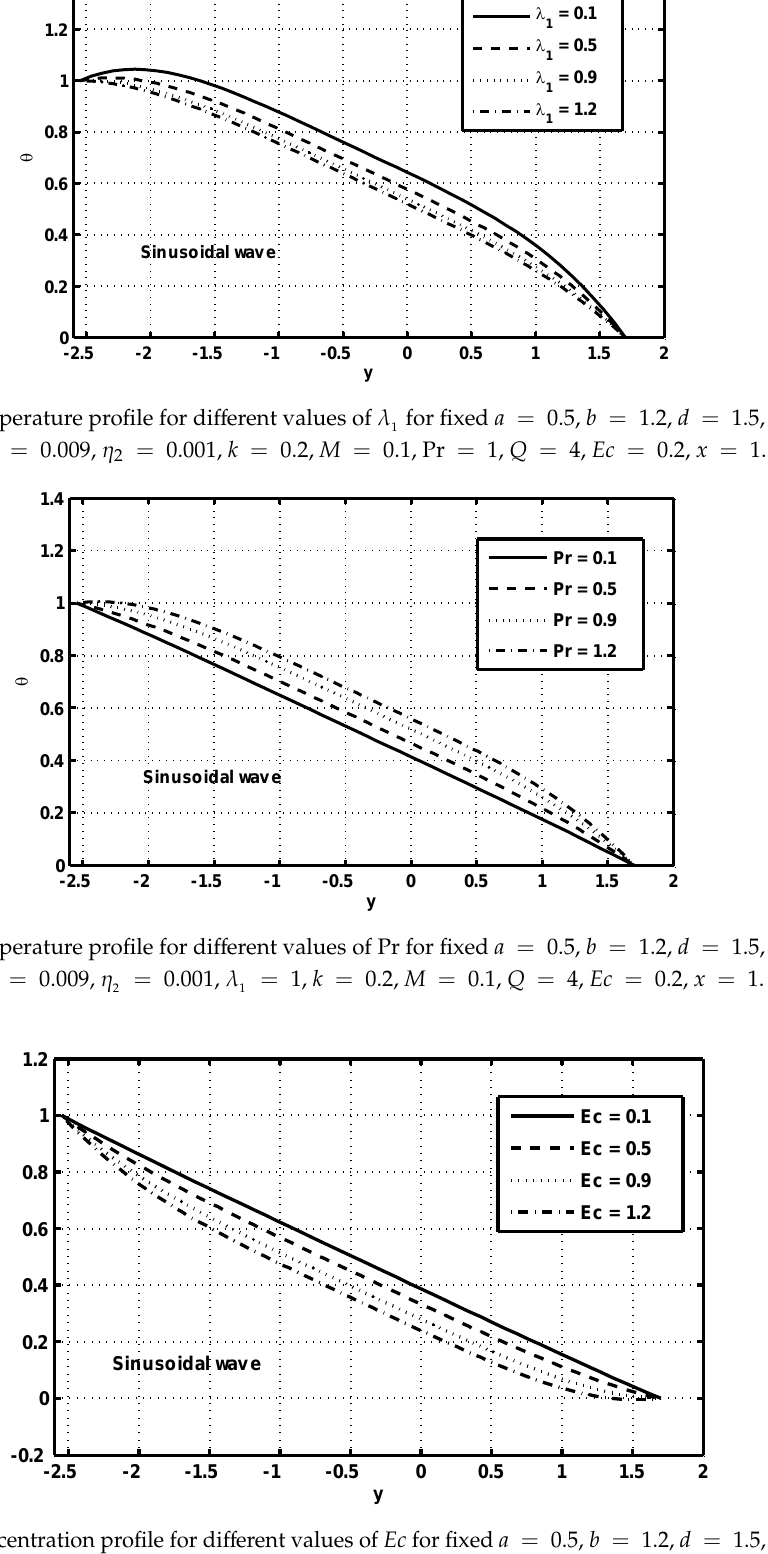
= 0.2, M = 0.1, Pr = 1, Q = 4, Sc = 0.3, 1